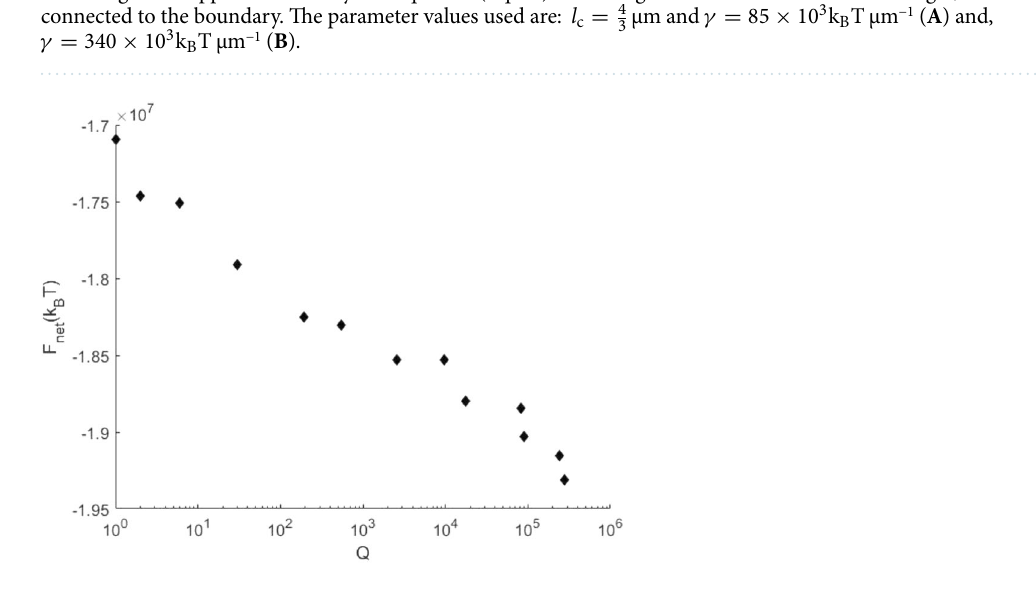
Figure 8. A semi-log plot illustrating the convergence of the lowest energy configuration using an ensemble of irregular realizations generated by random Voronoi tessellations. Q is the number of generated realizations. The results were obtained for the same system parameter values as in (Fig.